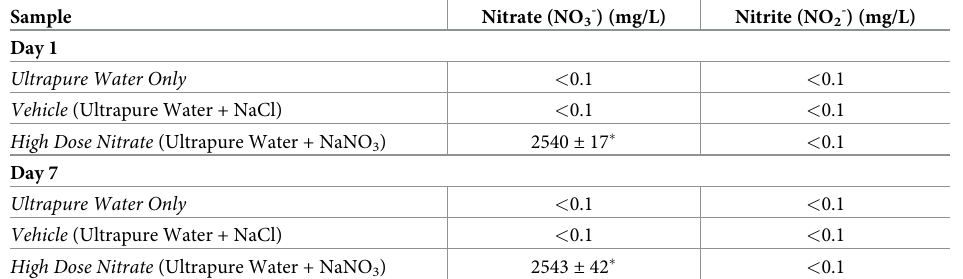
Table 3. Analysis of nitrate and nitrite levels in sodium chloride (NaCl) or sodium nitrate (NaNO 3 ) supplemented drinking water fed to wild-type and Pkd1 RC/RC mice when prepared fresh (day 1) and after 1 week (day